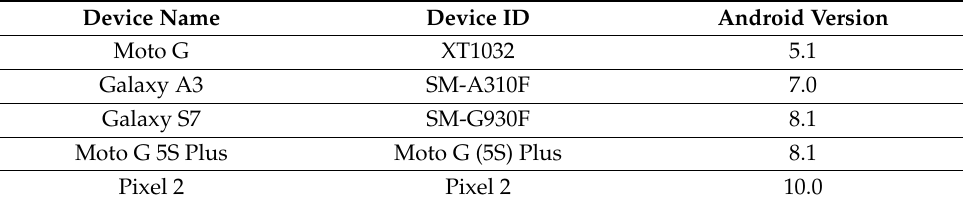
* marks device models that summarize multiple device IDs under a common device name (e.g., “Moto G *” summarizes the device IDs “Moto G”, “XT1028” and “XT1032”). These models can appear both as a single device model and as part of their group. Table 3. Final selection of device models and respective installed Android versions used for the